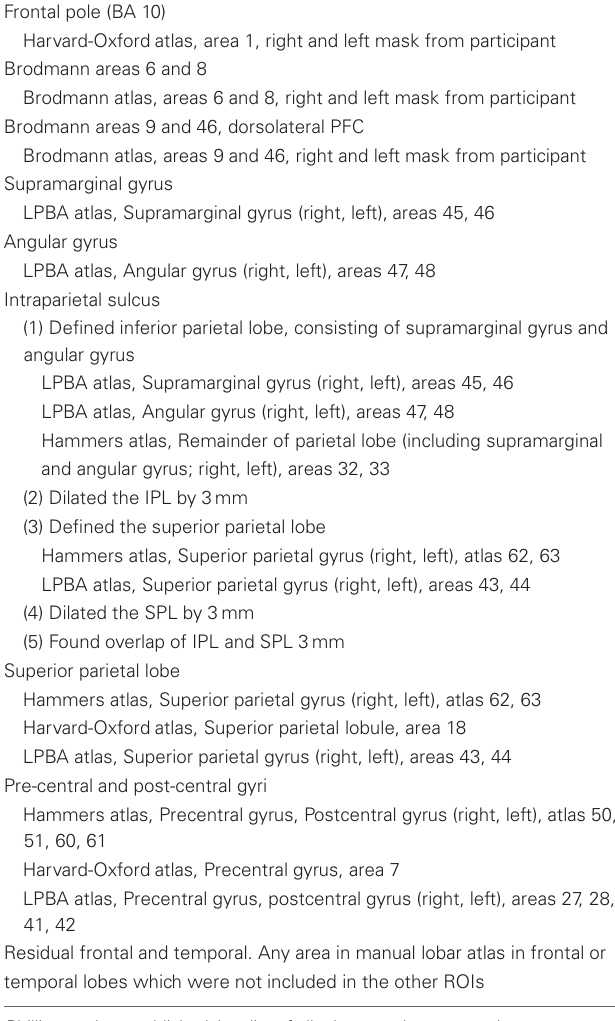
Table 3 | Regions-of-Interest for the individual participant atlases for lateralized areas (separate left, right